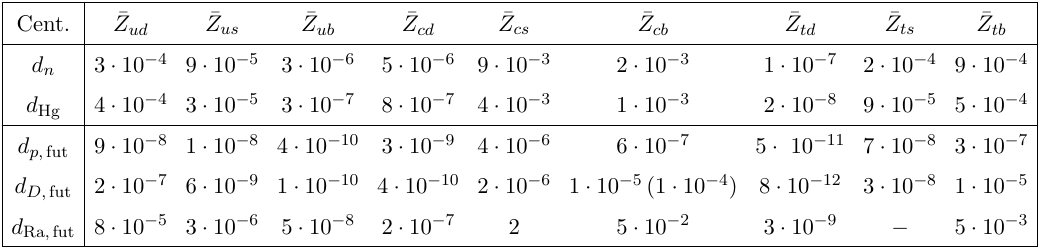
Table 8 . Limits on the S 1 di-quark couplings (cid:22) Z qq 0 (cid:17) m 2 values for all matrix elements. The limits in brackets denote constraints obtained with g c